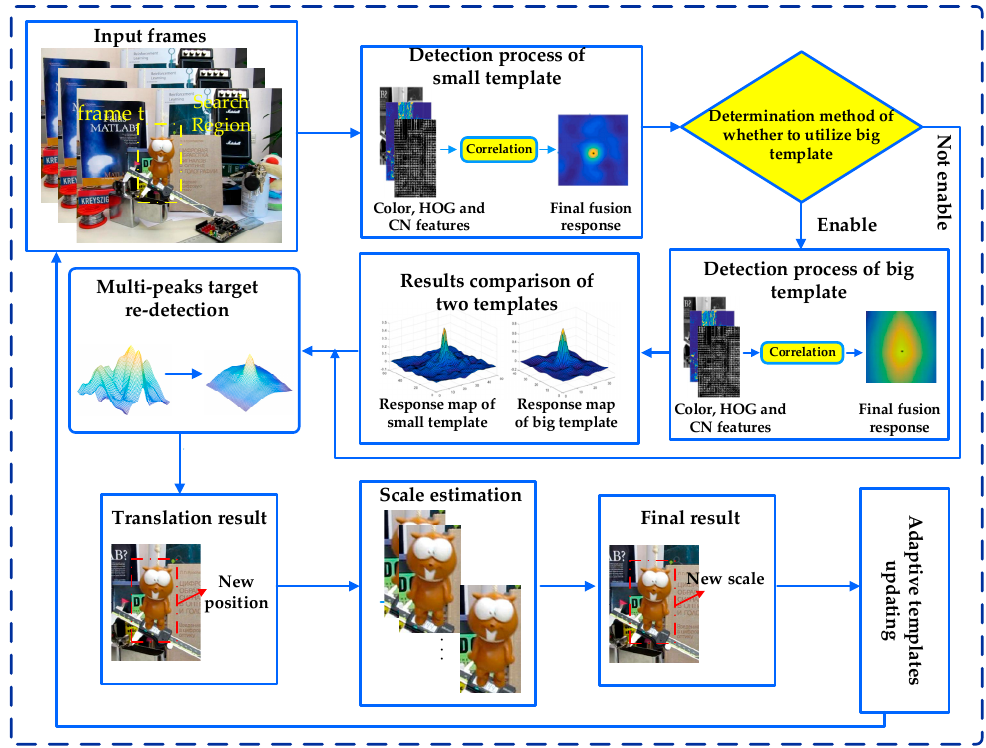
Figure 2. The framework of the proposed algorithm illustrated by the lemming sequence in frame t .